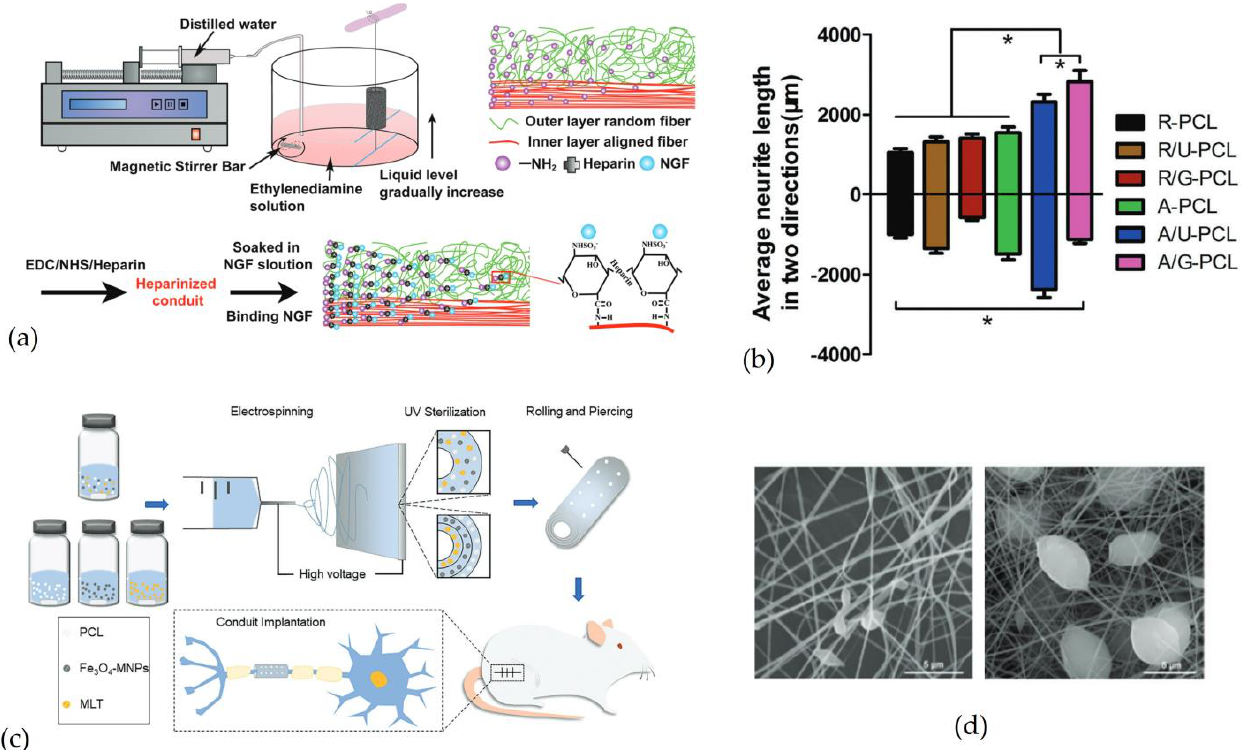
Figure 7. Nanofibers as drug delivery systems loaded in nerve guidance channels: ( a ) Representation of the NGC manufacturing process to create an NGF concentration gradient. Formation of NH 2 groups, in a gradient configuration, on PCL fibers in order to bind NGF by heparin. ( b ) Representation of average neurite length in two directions: random PCL fibers conduit (R-PCL), random PCL fibers conduit with uniform NGF (R/U-PCL), random PCL fibers conduit with gradient NGF (R/G-PCL), aligned PCL fibers conduit (A-PCL), aligned PCL fibers conduit with uniform NGF (A/U-PCL) and aligned PCL fibers conduit with gradient NGF (A/G-PCL). (* = p < 0.01) Reproduced and adapted